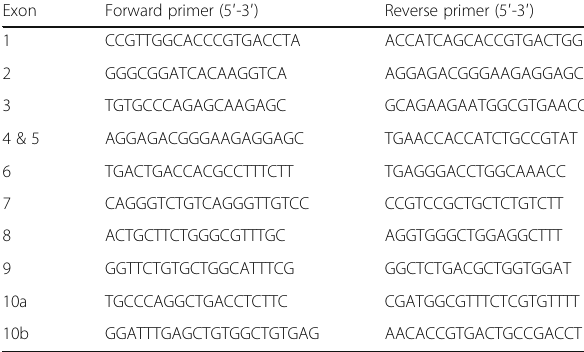
Table 1 Primers for exon-specific sequencing of STK11 gene Exon Forward primer (5 ′ -3 ′